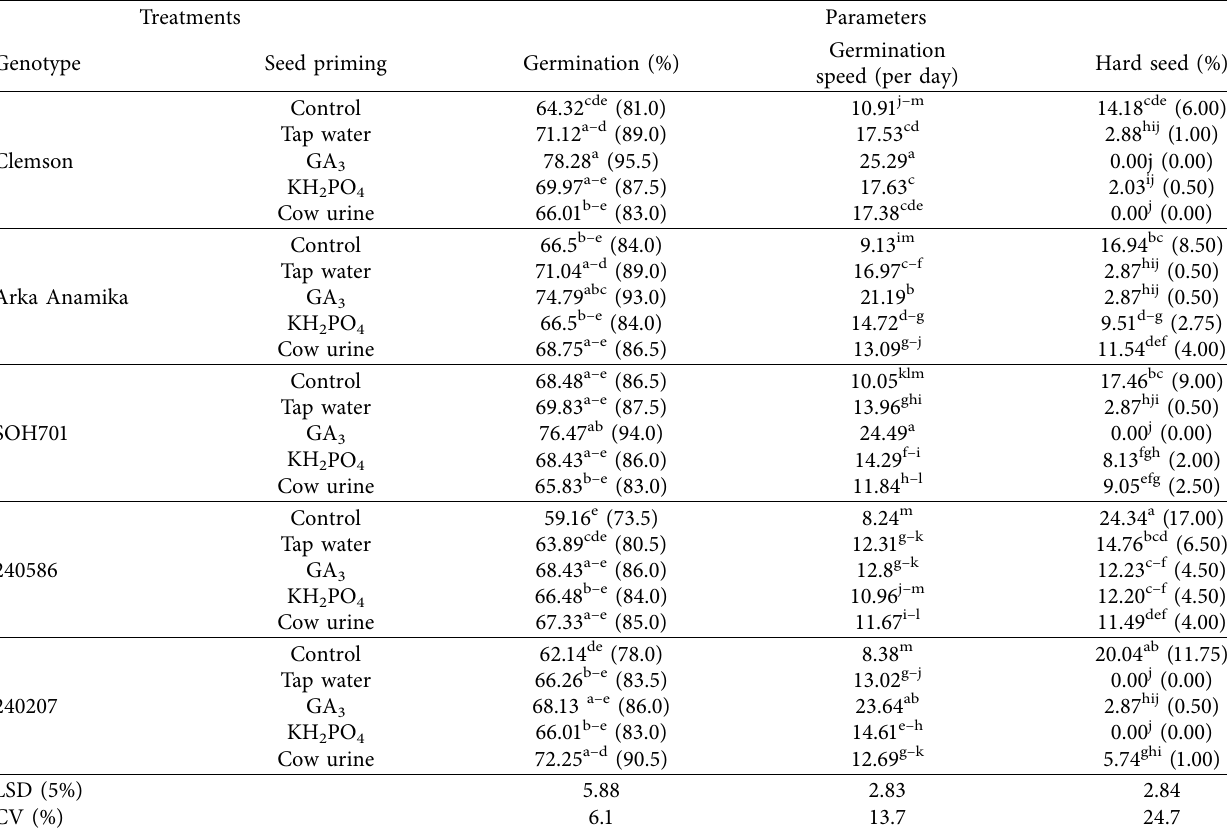
Table 5: Interaction efects of genotype and diferent priming on germination percentage, germination speed, and number of hard seeds.